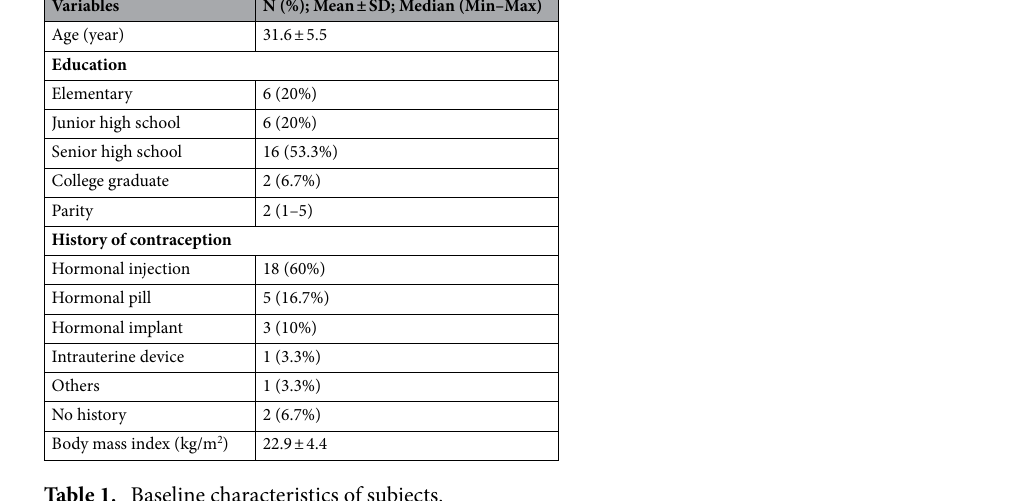
Table 1. Baseline characteristics of